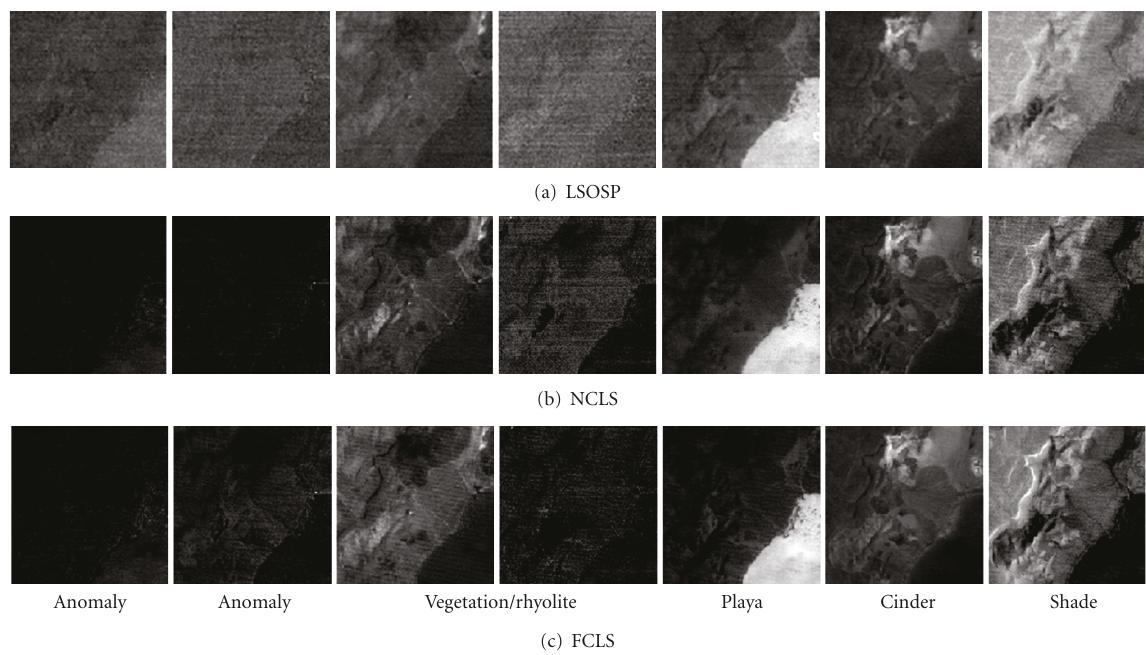
Figure 30: LSOSP, NCLS, and FCLS unmixed results using the samples extracted in Figure 29(d).